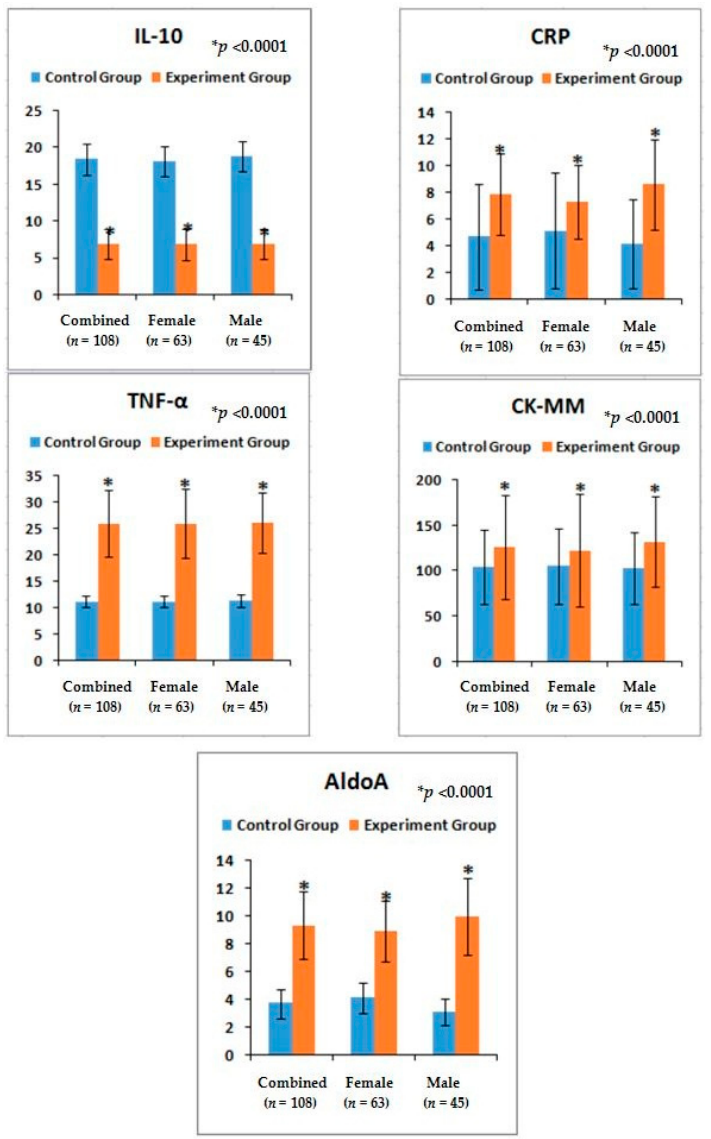
Figure 4. Graphical representation of biochemical parameters for IL-10, TNF- α , CRP, CK-MM, and AldoA in comparisonwith control and experimental groups and their p -values .